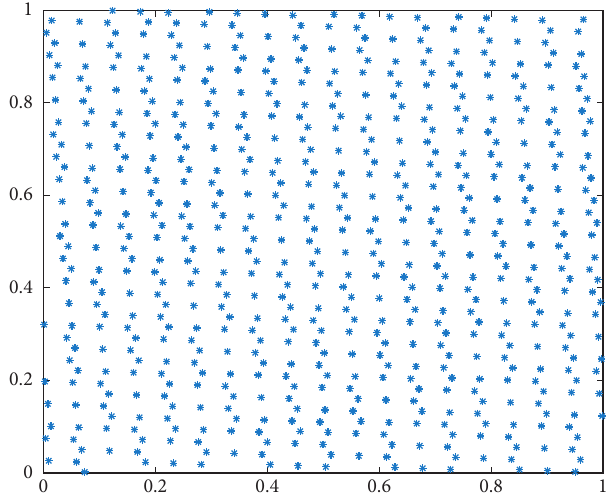
Figure 2: Two-dimensional initial populations generated by the good point set method ( N � 600).